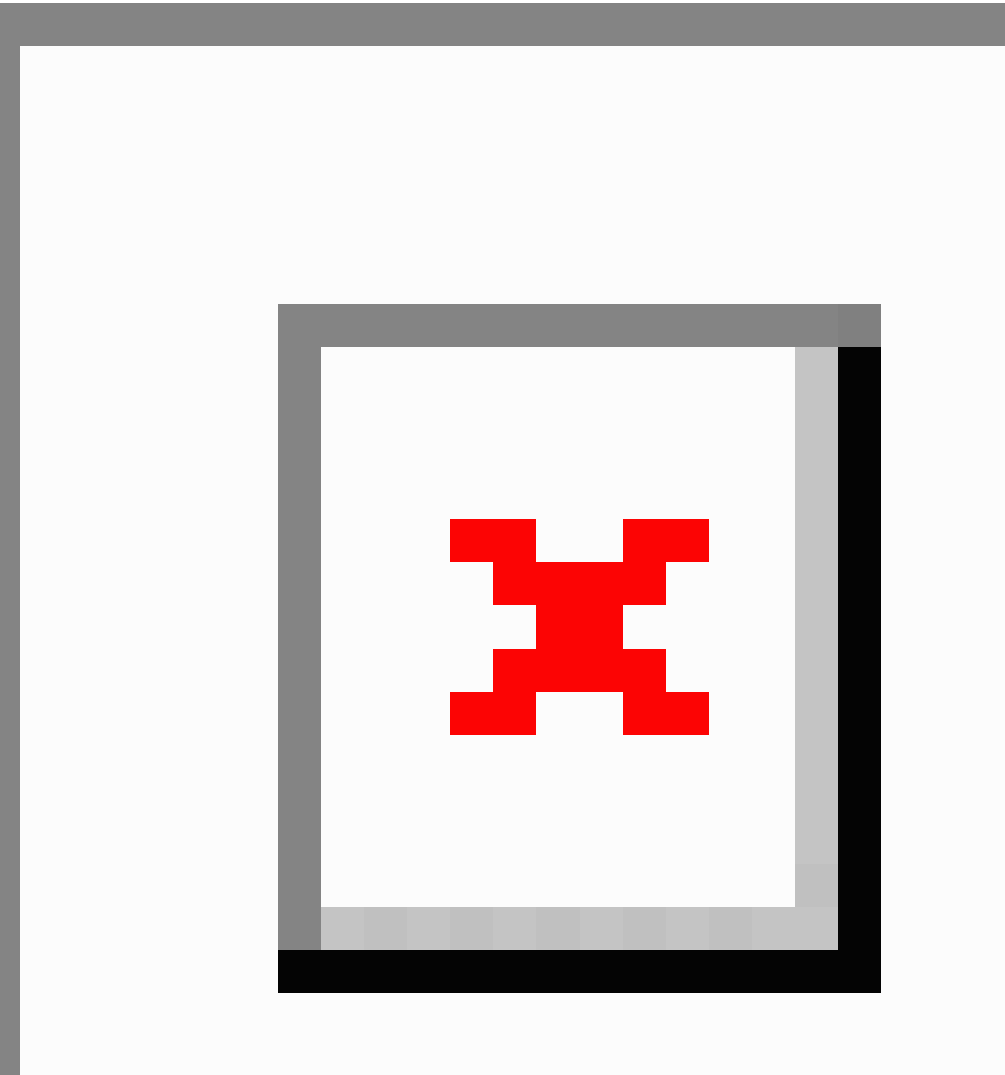
Figure 1. Sina Weibo webpage of a Center for Disease Control and Prevention facility in